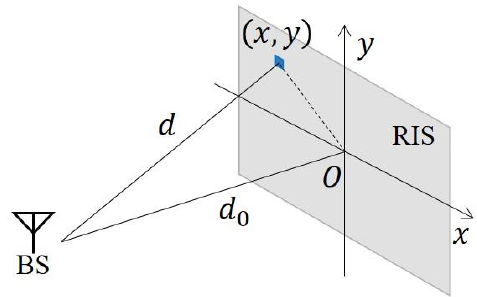
Figure 7. The distance from BS to RIS-reflection units.